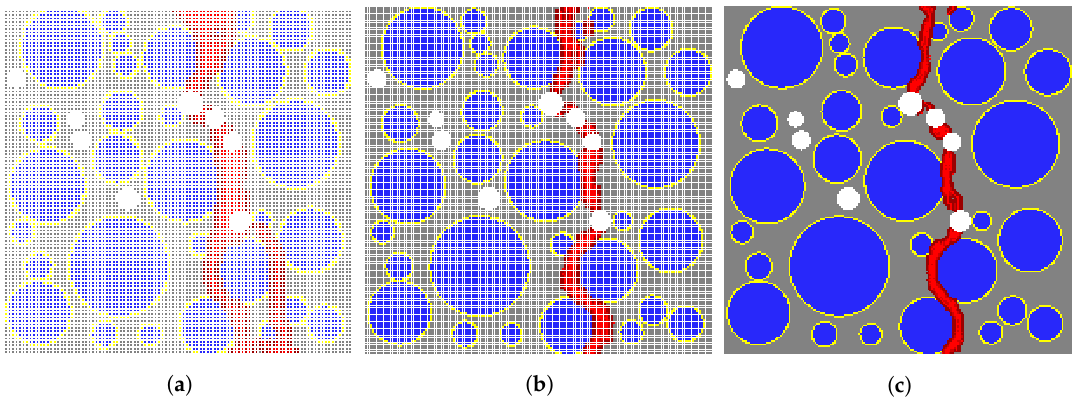
Figure 8. Effect of particle spacing size on crack pattern. ( a ) h = 1/2 mm; ( b ) h = 1/3 mm; ( c ) h = 1/4